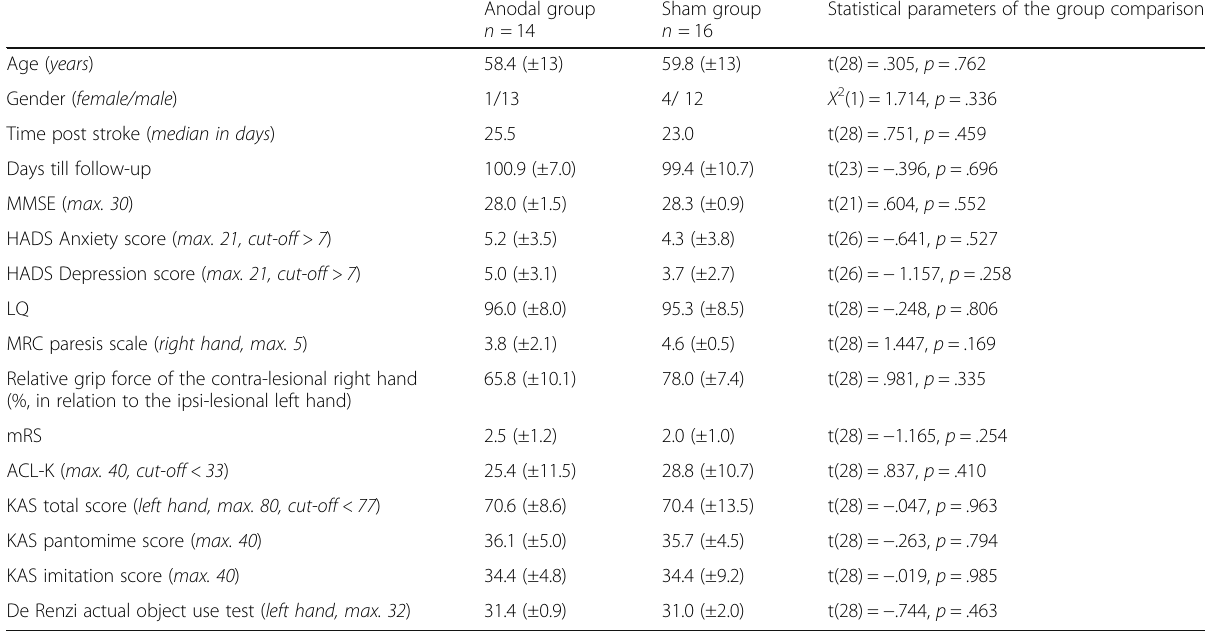
Table 1 Demographic, clinical and neuropsychological data of the LH stroke patient groups undergoing anodal or sham tDCS (applied over left posterior parietal cortex, PPC)